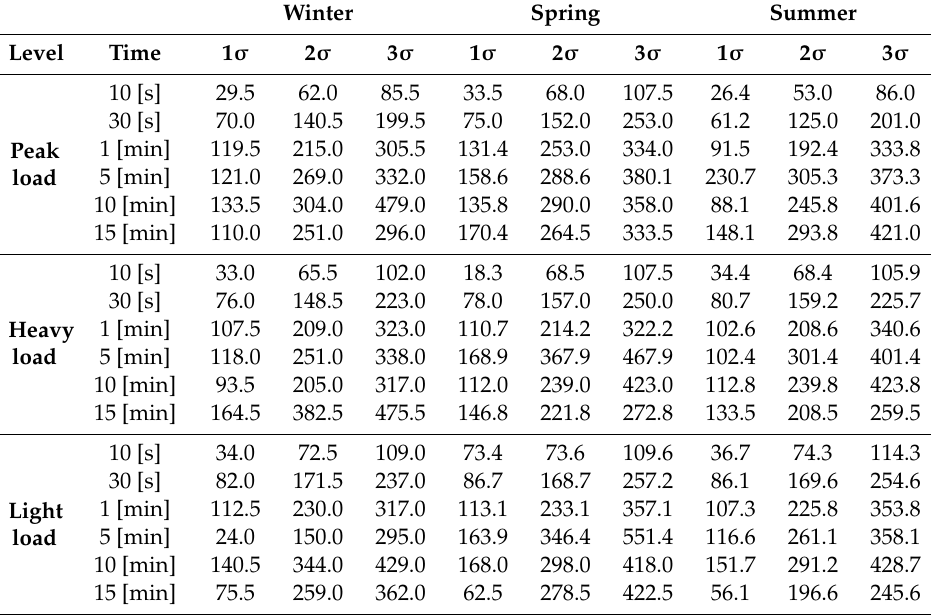
Table 5. The load fluctuation magnitude of total steel